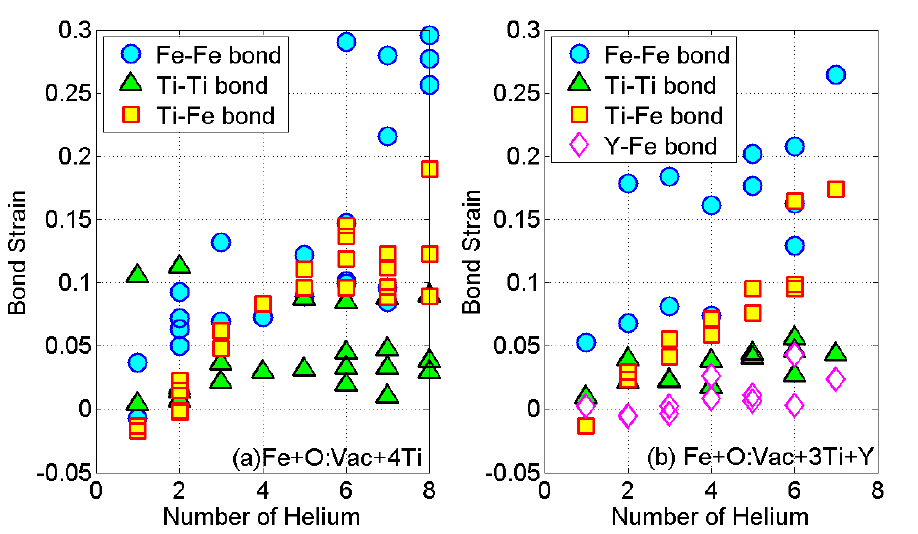
Figure 8. ( a ) bond strain variation of the reference unit of Fe + O:Vac + 4T; ( b ) bond strain variation of the reference unit of Fe + O:Vac + 3Ti +